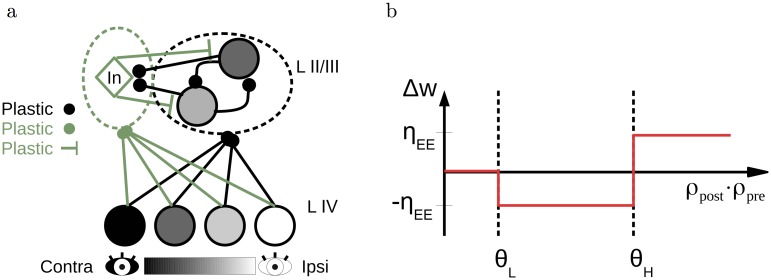
Schematic of the network and excitatory learning rule.(a) A cartoon of the network architecture. A population of presynaptic (layer IV) neurons with various ODIs makes feedforward connections onto layer II/III excitatory and inhibitory neurons. Within the layer II/III, excitatory neurons have recurrent connections both to other excitatory neurons as well as to the inhibitory neurons, which in turn project back onto the excitatory neurons. (b) Schematic of the E-to-E plasticity rule. Low values for the product of presynaptic and postsynaptic rates do not lead to plasticity. Intermediate values result in synaptic depression, and high values in synaptic potentiation.